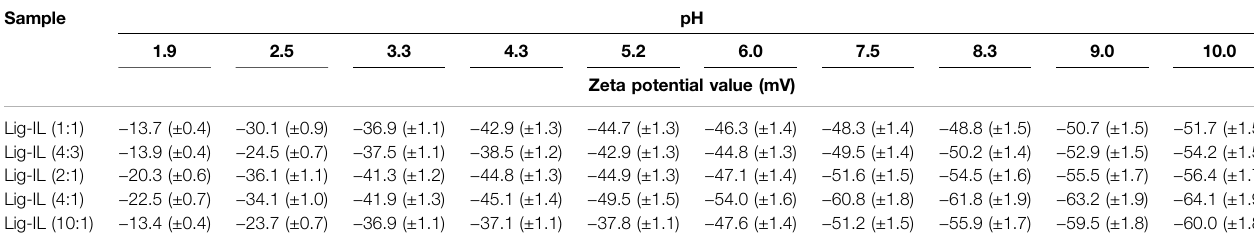
TABLE 4 | Zeta potential values for all materials in different pH values.